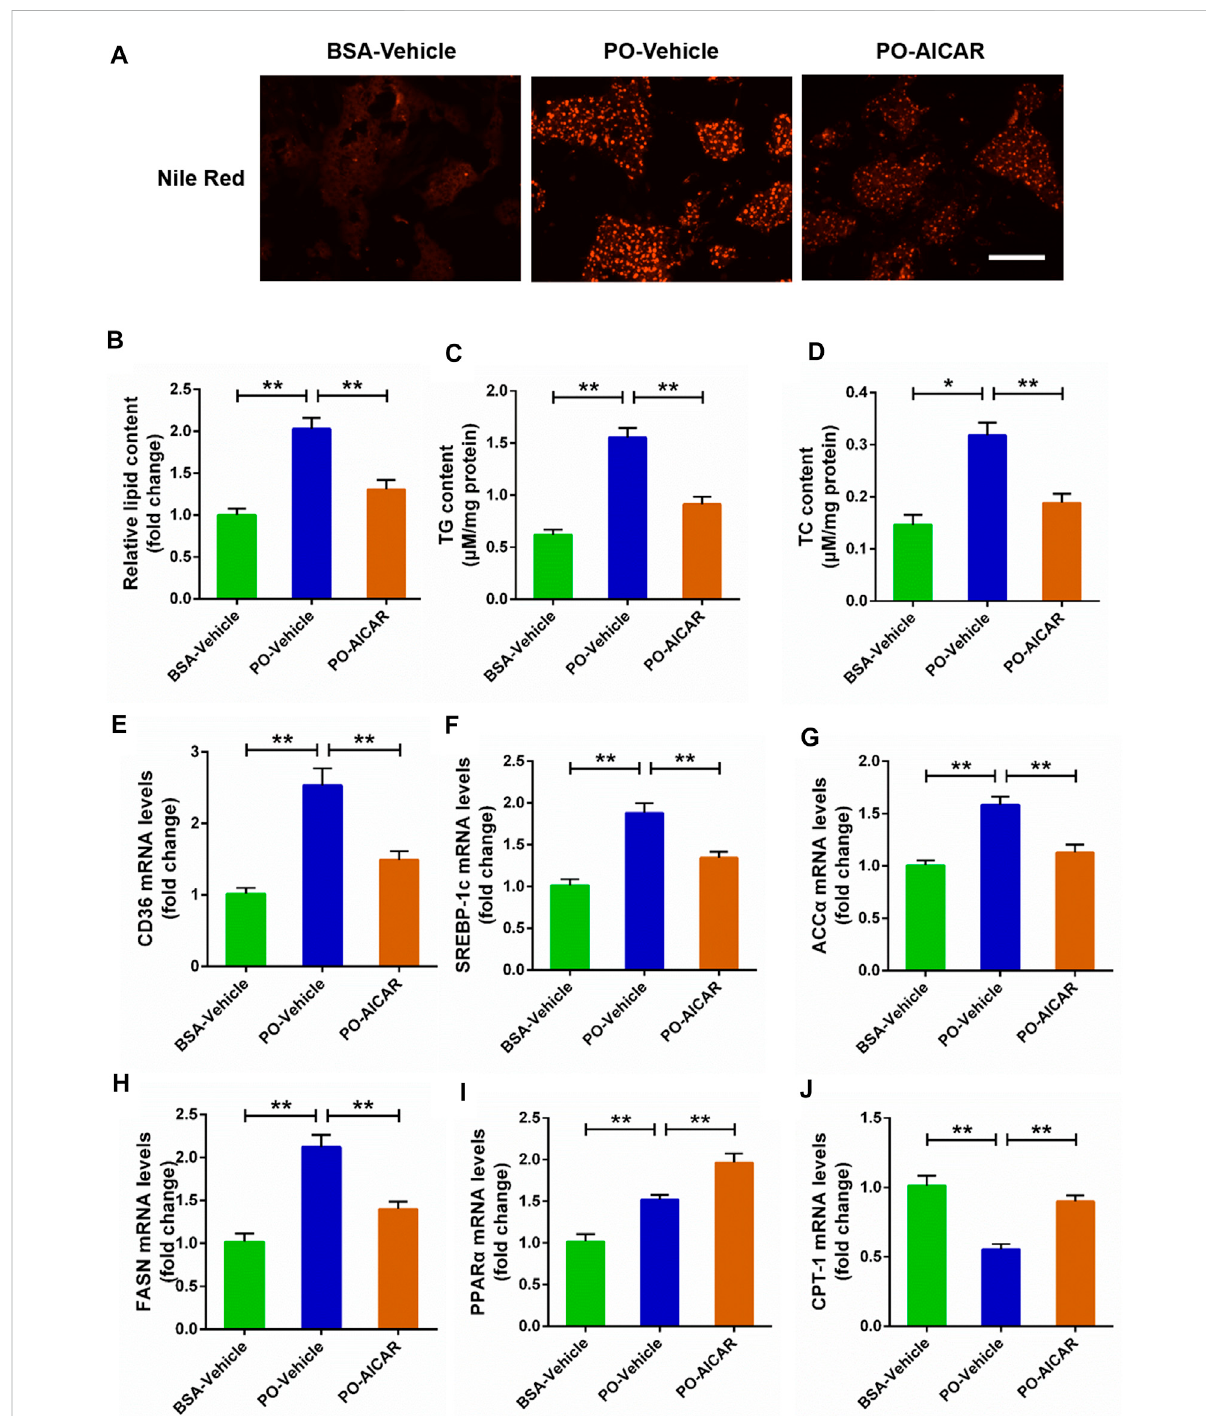
FIGURE 3 AICAR alleviates the lipid metabolism disorders induced by PO in primary chicken hepatocytes. The primary chicken hepatocytes were pre- treated with/without 1 mM AMPK activator AICAR for 1 h, and then stimualted with/without 0.75 mmol PO for another 24 h. (A) Photography of lipid droplet accumulation by Nile Red staining (scale bars, 100 μ m); (B) Relative of lipid droplet content; (C) Triglyceride (TG) content; (D) Total cholesterol (TC) content; (E) Fatty acid translocase (CD36) mRNA levels; (F) Sterol regulatory element binding protein 1c (SREBP-1c) mRNA levels; (G) Acetyl-CoAcarboxylase α (ACC α )mRNAlevels; (H) Fattyacidsynthase(FASN)mRNAlevels; (I) Peroxisomeproliferatoractivatedreceptor α (PPAR α ) mRNA levels; (J) Carnitine palmitoyl transterase-1 (CPT-1) mRNA levels. Values represent the means ± SE. * p < 0.05 and ** p < 0.01, signi fi cantly different between the indicated treatment